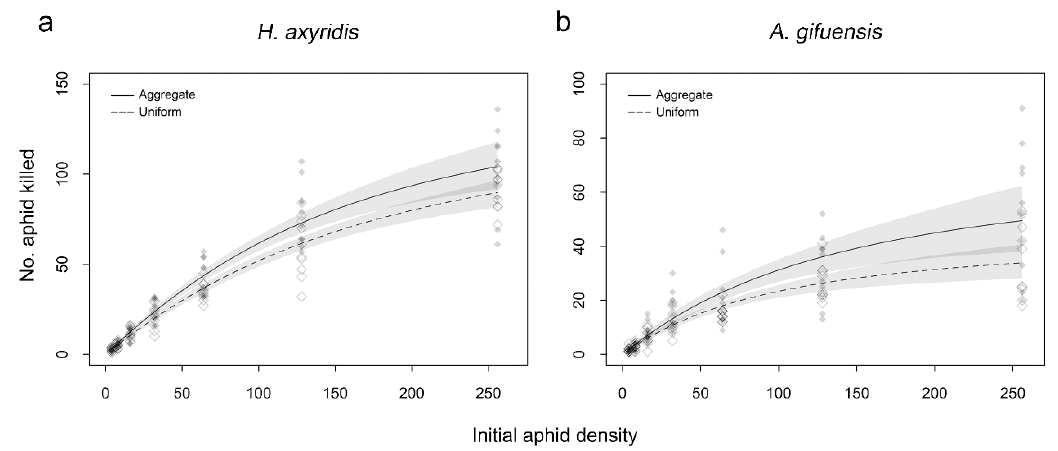
Figure 1. Functional response of single Harmonia axyridis ( a ) or Aphidius gifuensis ( b ) to densities of